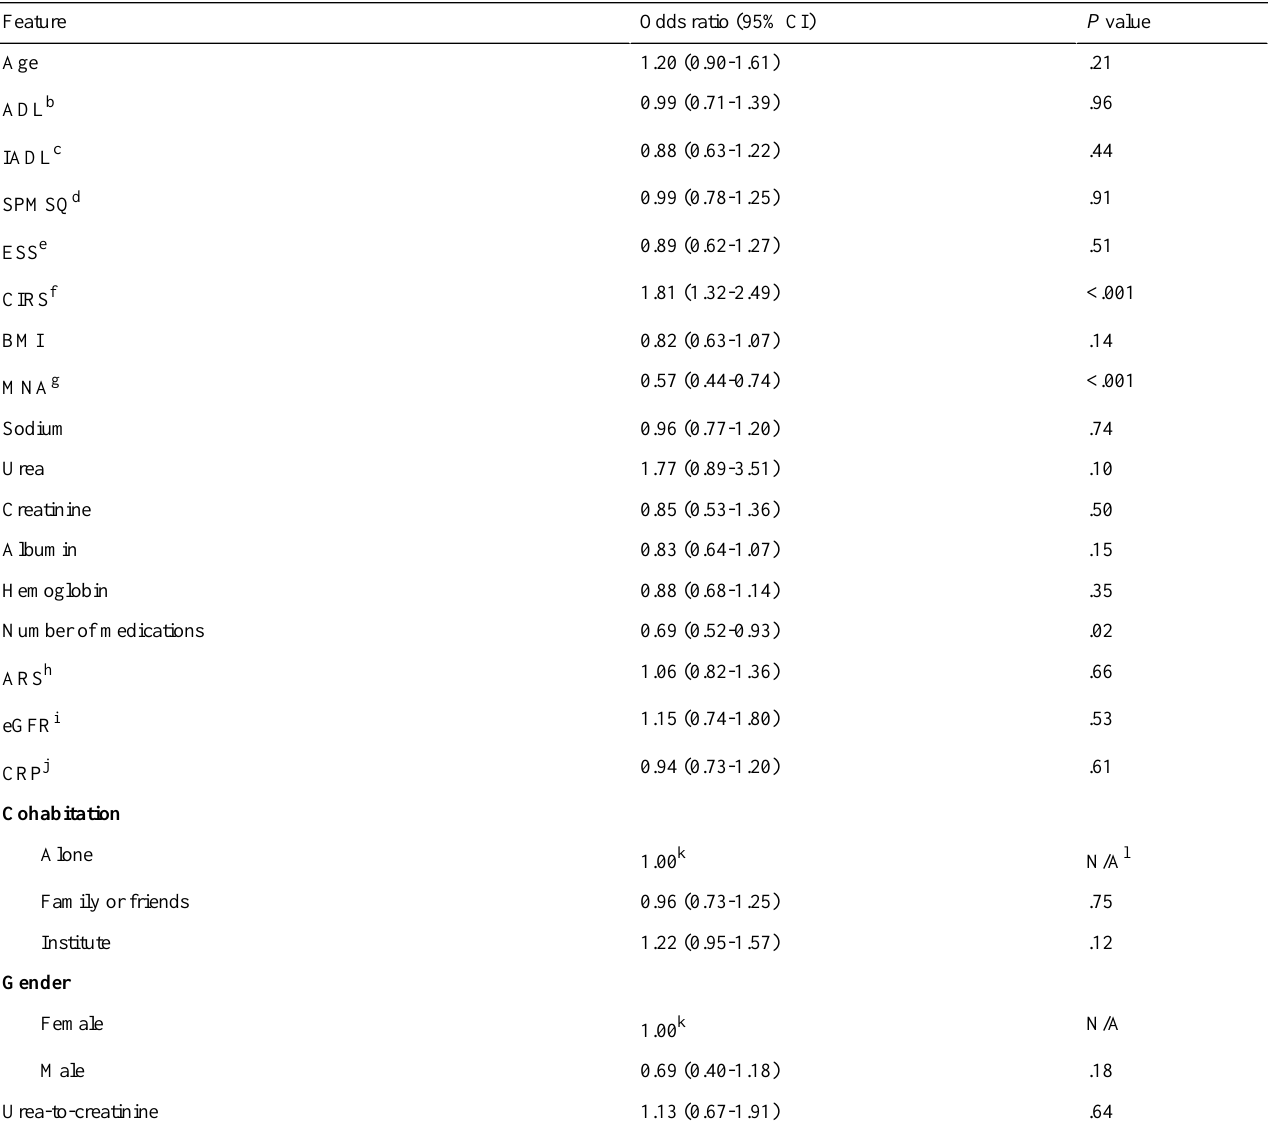
Table 3. Odds ratios (95% CIs) for the logistic regression with maximum likelihood estimation model using the test data with feature set 4 a